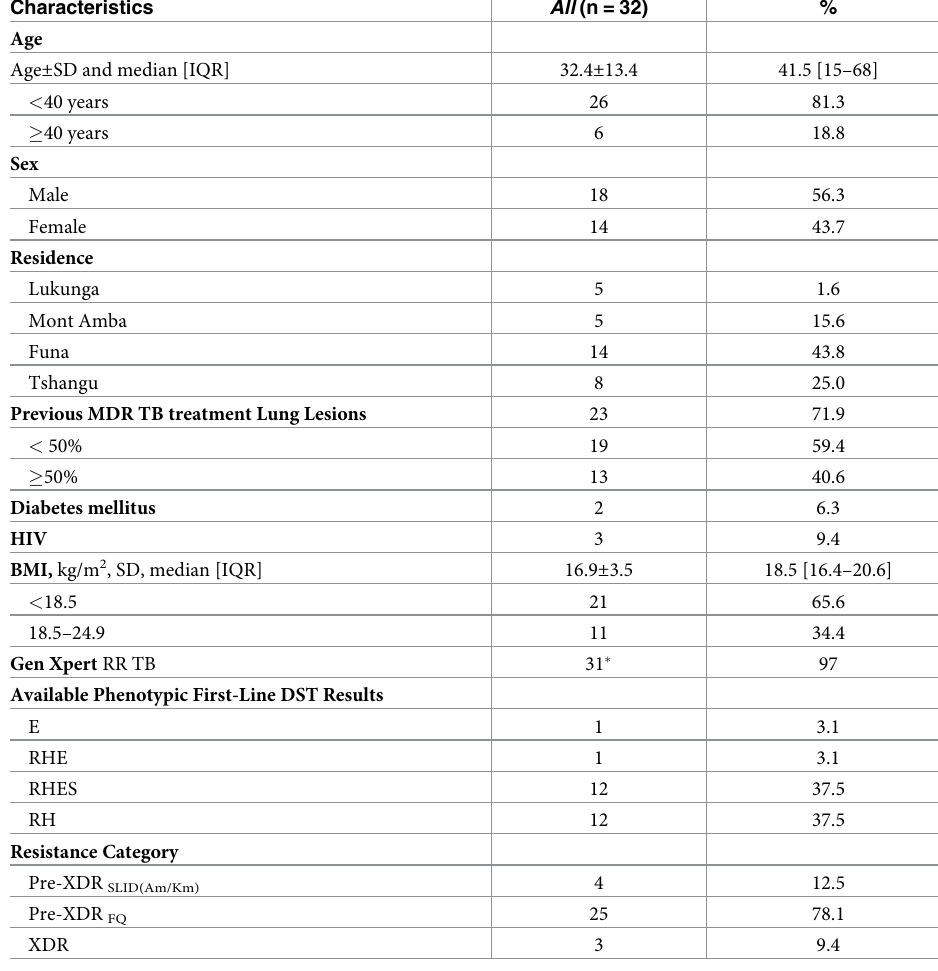
Table 1. General characteristics and available drug susceptibility testing